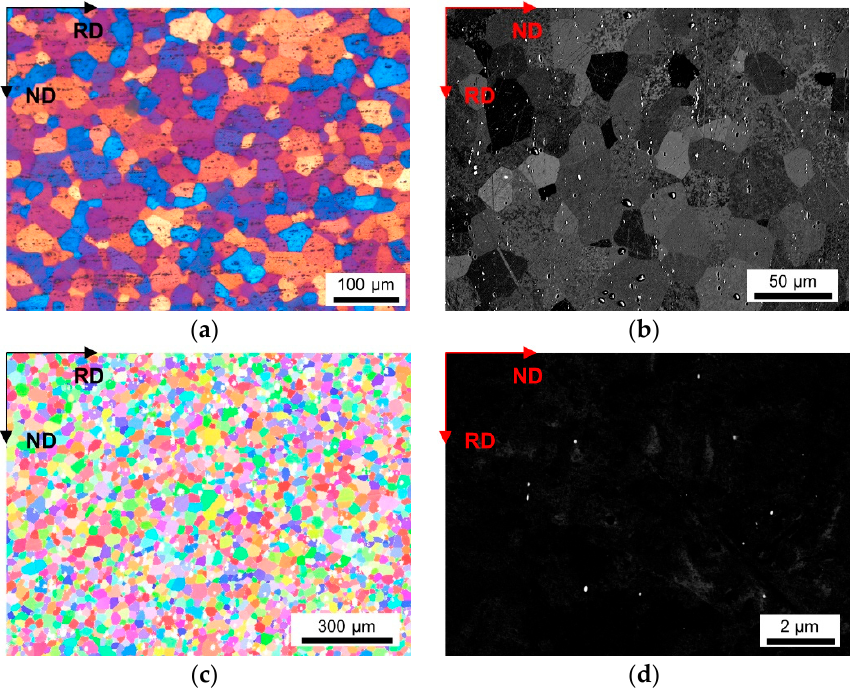
Figure A6. Microstructure of the soft annealed LFe-LMn cast under NR-C condition, homogenized at 550 °C and cold rolled to a CRD of 35%. ( a ) LOM. ( b ) BSE image. ( c ) EBSD IPF map in RD–ND plane. ( d ) BSE micrograph showing dispersoids.